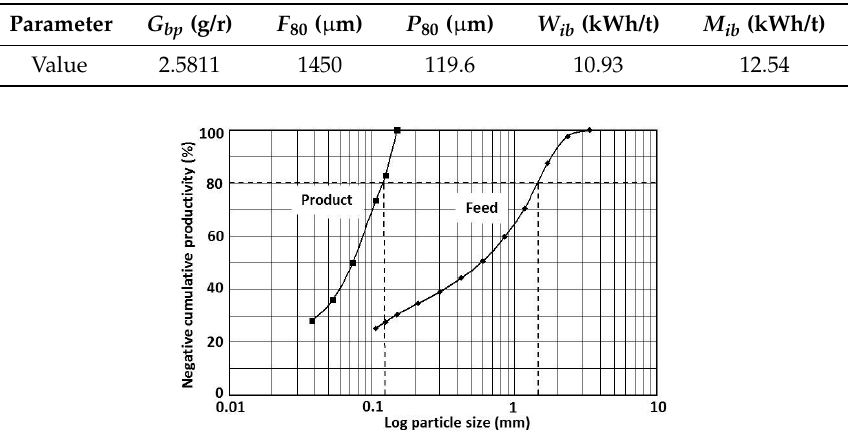
Figure 4. Particle size distribution of Bond ball work index test.